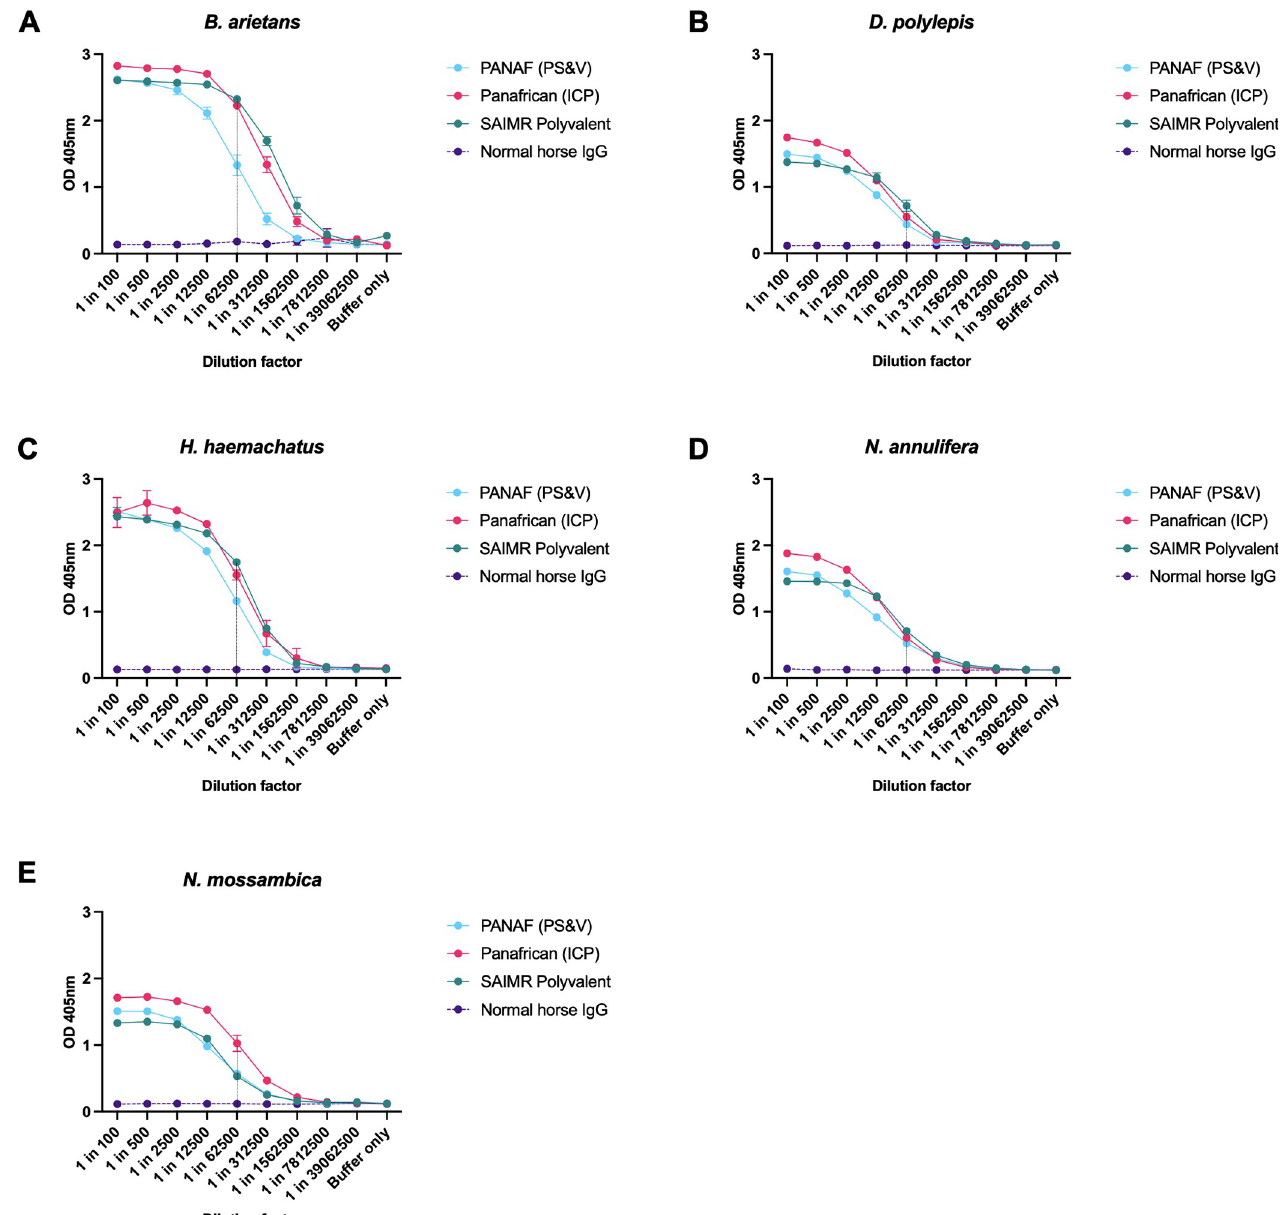
Fig 2. The titre of three antivenoms against five Eswatini venoms determined by end-point titration ELISA. SAIMR Polyvalent (SAVP) shown in teal, Panafrican (ICP) shown in magenta, PANAF (PS&V) shown in blue, normal horse IgG shown in purple. Panel A: B . arietans . Panel B: D . polylepis . Panel C: H . haemachatus . Panel D: N . annulifera . Panel E: N . mossambica . Data points represent the mean of two replicates and error bars show the standard deviation. The vertical line at the 1 in 62,500 dilution represents the point at which Ig titres of each antivenom were compared.